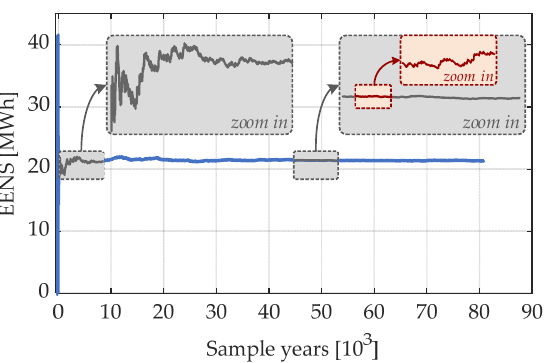
Figure 7. EENS vs. sample years convergence trajectory for a BESS of 30 MW/5.8 h operating under